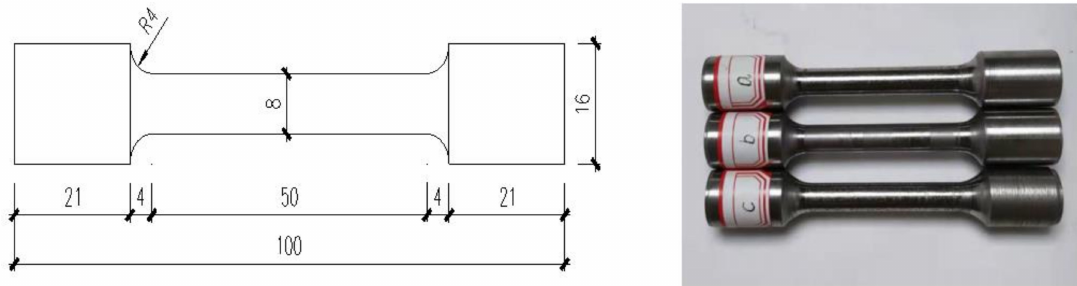
Figure 3. Standard tensile specimen for M24 torsional shear-type high-strength bolt.